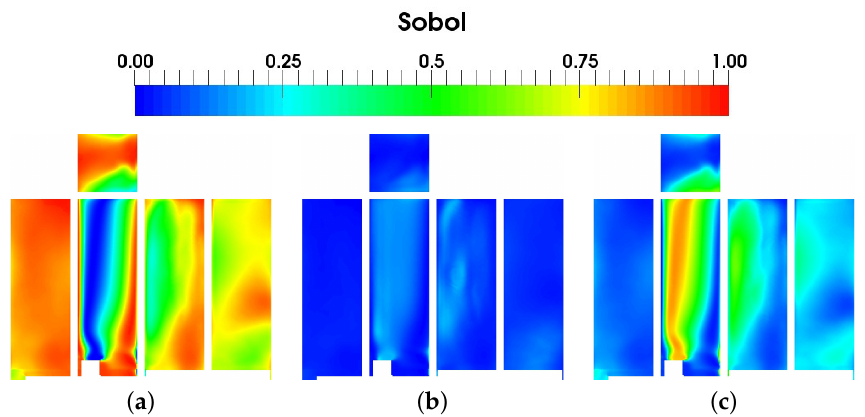
Figure 19. Sobol indices of the mean pressure on building walls computed from c-APK model for ( a ) α index, ( b ) α − θ index and ( c ) θ index. The building faces are presented here, from left to right, in the order east, north, west and south, with the top face on top of the figure.